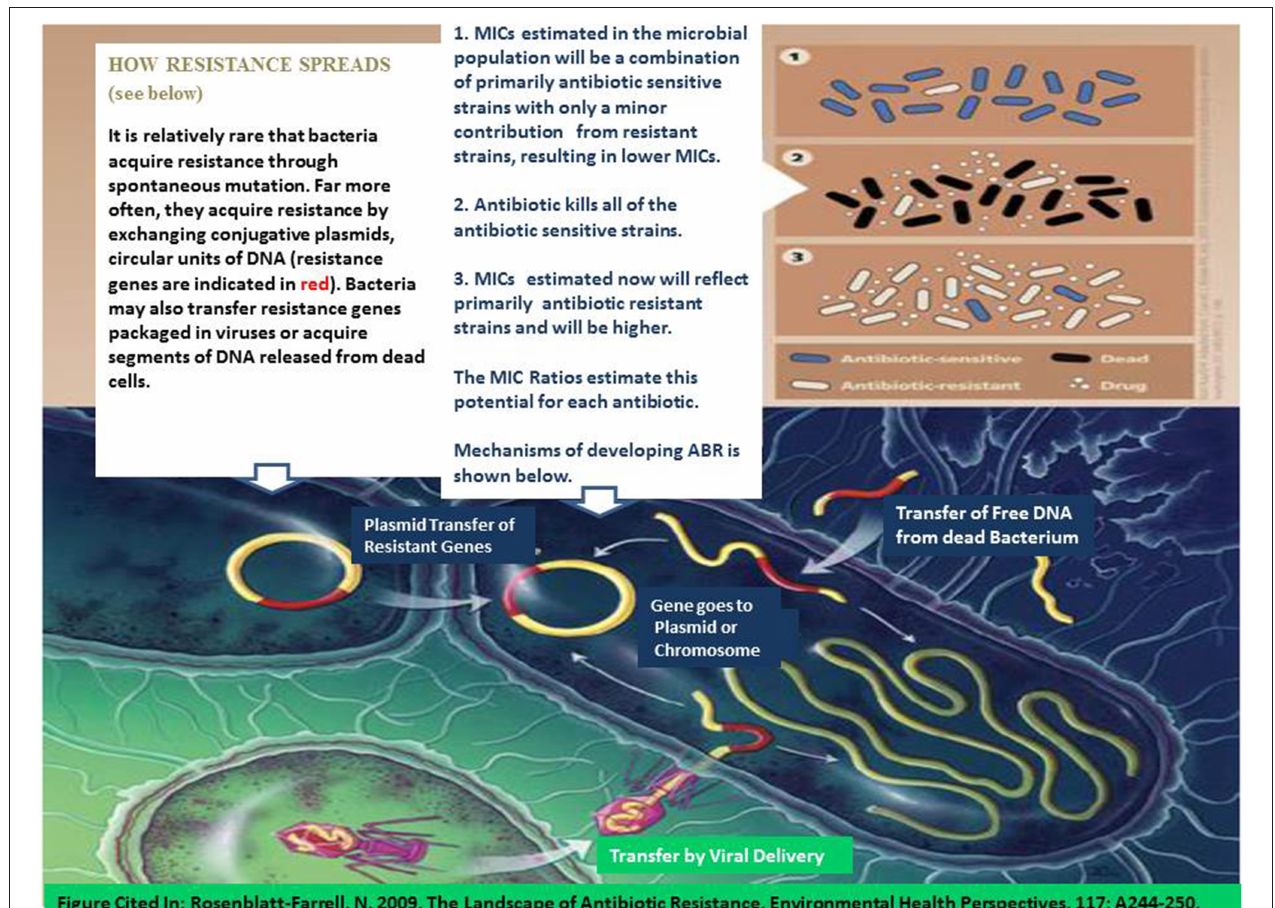
FIGURE 2 | Mechanisms for development of antibiotic resistance (modified after Rosenblatt-Farrell, 2009). The landscape of antibiotic resistance. Environ Health Perspect . 117: A244-A250). Top portion of the figure: (1) Most bacteria are antibiotic sensitive (blue) and not resistant (white). (2) Exposure to an antibiotic at or above the MIC results in mortality (black) in most antibiotic sensitive bacteria. (3) This leaves behind more antibiotic resistant bacteria which will have a higher MIC as a result. Mechanisms for acquiring ABR are depicted in the bottom part of the